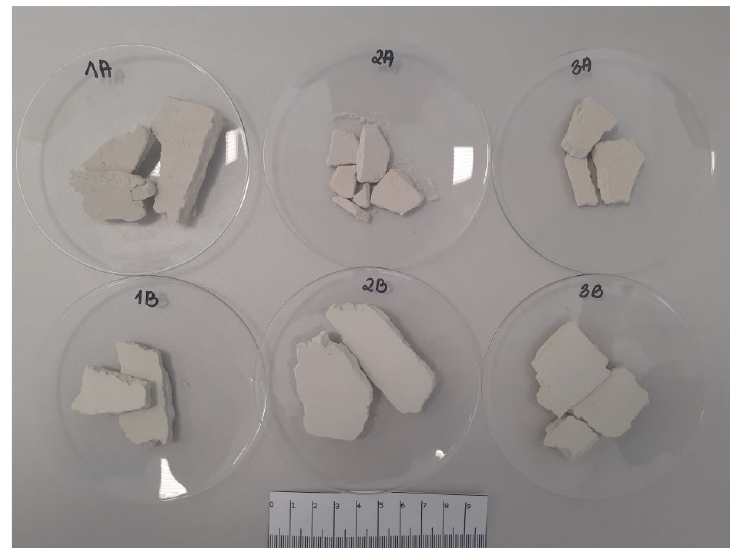
Figure 5. Produced ribbons (first step of the dry agglomeration).